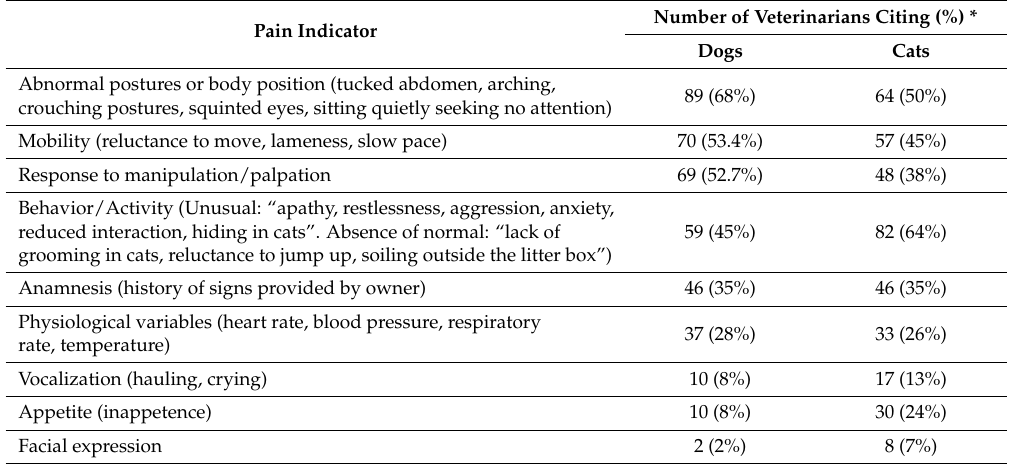
Table 2. Ranking of pain indicators considered most useful in dogs and cats by 131 veterinarians in the city of Medellin, Colombia.